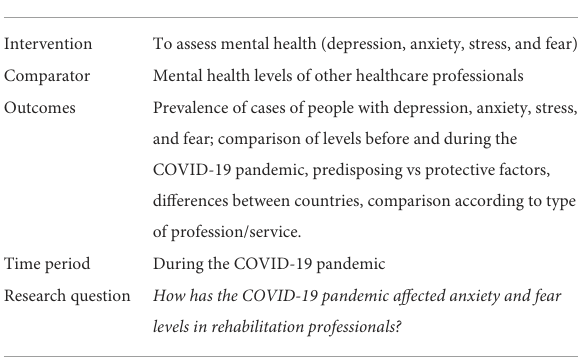
TABLE 1 PICO format: keywords (rehabilitation and COVID-19, Spain, 2022). Population